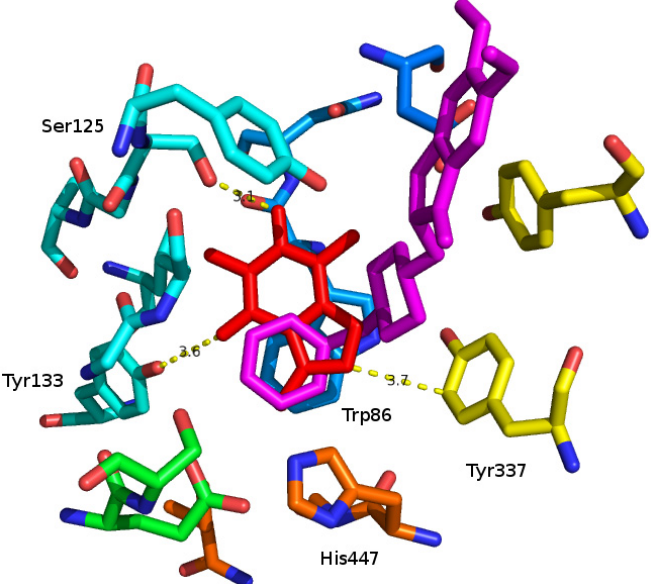
Figure 3. The internal cavity of human AChE is visualized with the predicted binding orientation of caffeine, which is colored by red; the docked orientation of donepezil is colored by violet. Trp86 creating a stacking interaction is situated below the docked orientation of caffeine. Furthermore, there are other important amino acids having an interaction with caffeine (Ser125, Tyr133 and Tyr337). Additionally, His447 creates part of the active site for